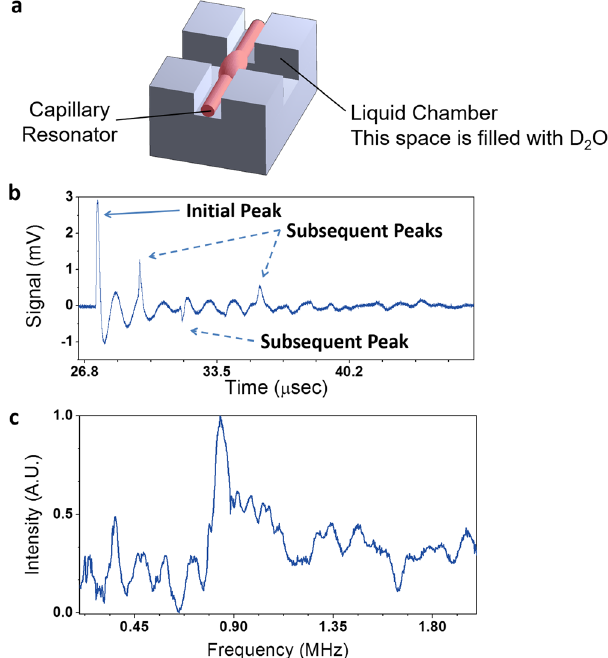
Figure 7. ( a ) Schematic of the chamber to immerse the ring resonator (colored in red) into D 2 O. The optical taper was placed on top of the ring resonator. The air-gap between the Cr film and the D 2 O chamber was ~1.4 mm. The distance between the top surface of D 2 O and the ring resonator was 2.0 mm. ( b ) Air-coupled PA signal detected by the ring resonator ( a = 65 μ m, t = 7.5 μ m), immersed in D 2 O. The data were averaged 64 times. The PA peak around 27 μ s was the signal from the PA pulse. The dampened “ringing” response can be seen after the initial peak signal. ( c ) Frequency response of the ring resonator towards PA pulse. A broadened peak at 840 kHz with a FWHM of 200 kHz can be obtained with D 2 O